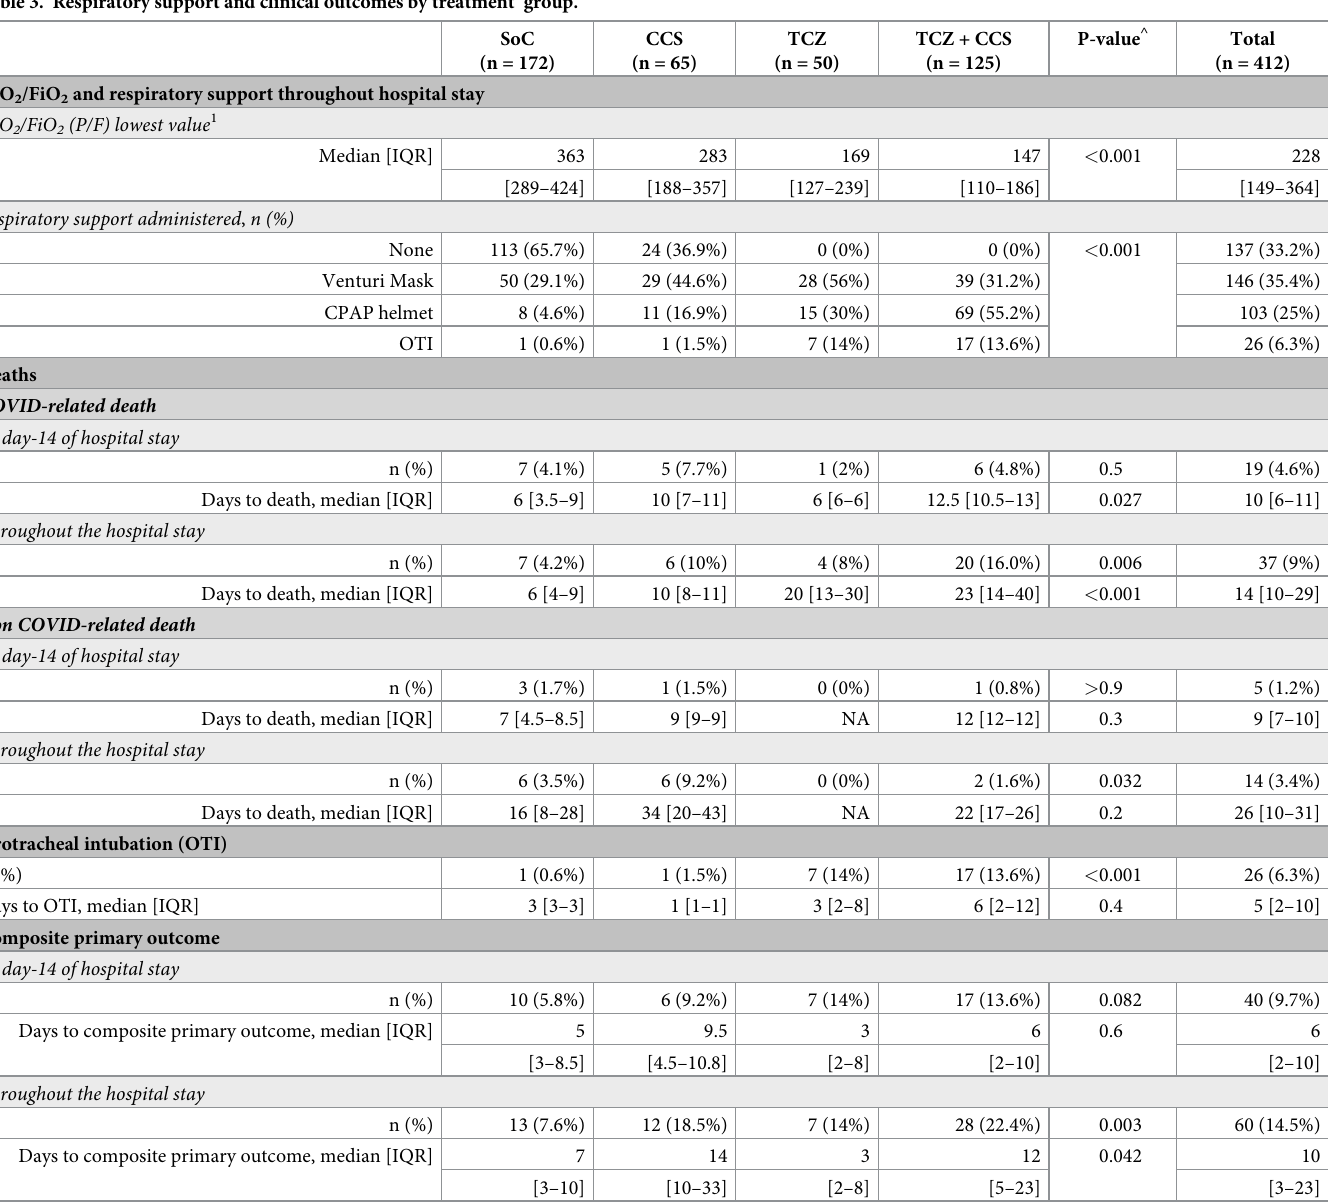
Table 3. Respiratory support and clinical outcomes by treatment’